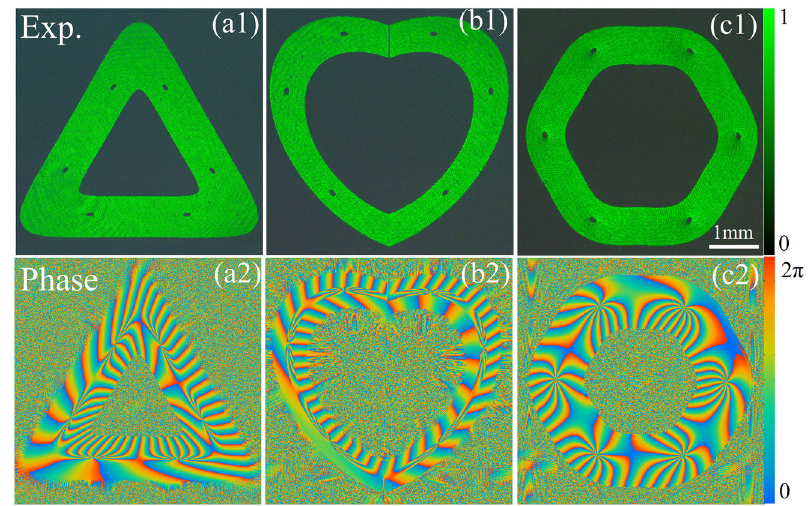
Figure 8: HO-OVL with versatile modes. (a1) – (c1) Intensity patterns of triangular, heart-like, and hexagonal HO-OVLs. (a2) – (c2) Corresponding phase distribu- tions of (a1) – (c1). l = 10 in all